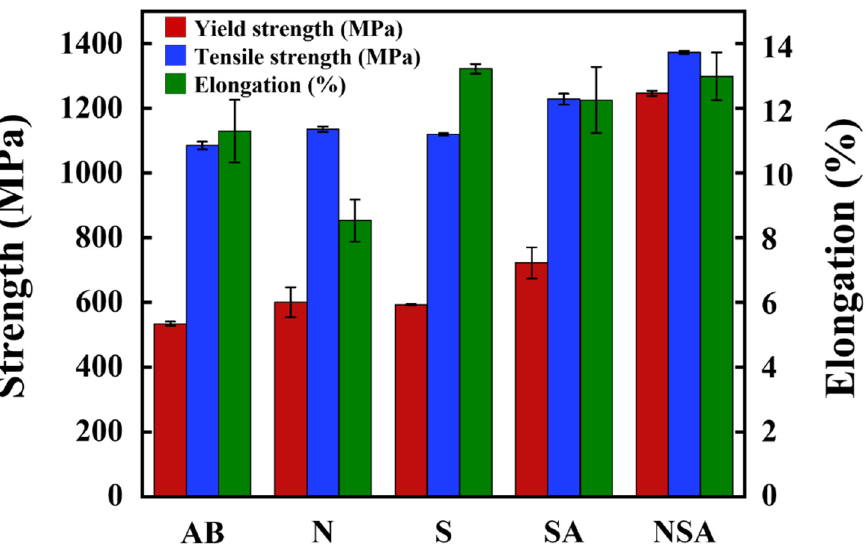
Figure 4. Yield strength, tensile strength, and elongation for the L-PBF as-built and heat-treated 17-4 PH sample.